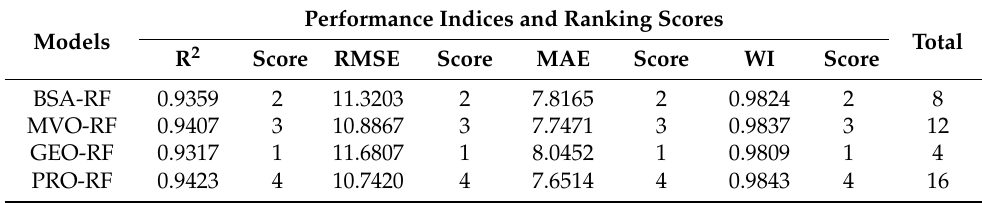
Table 3. Performance and ranking results of four hybrid RF models in the training